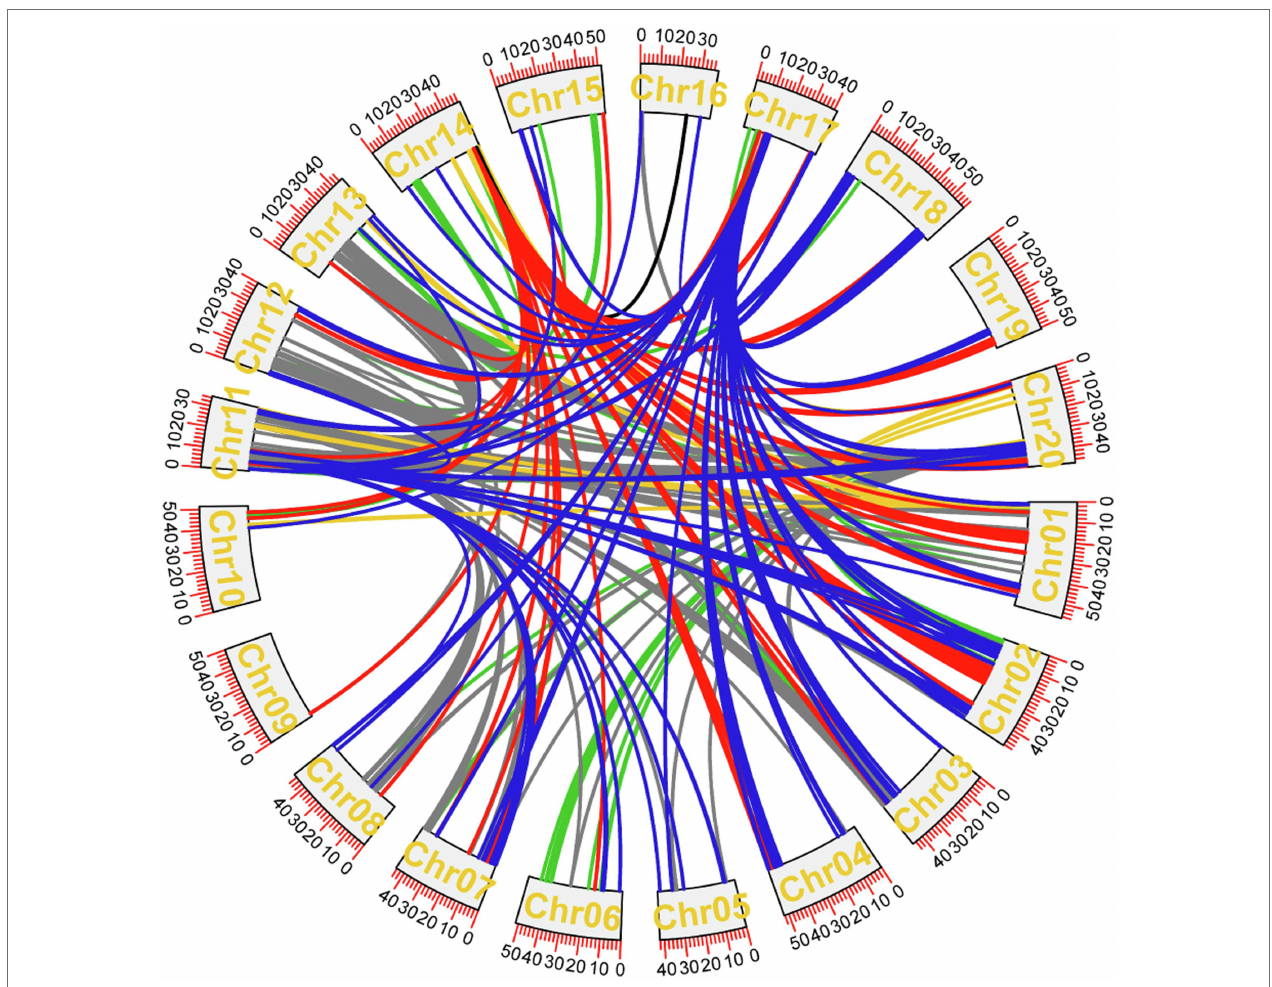
FIGURE 8 | Epistasis analysis of CSSLs. Epistasis of seed-pod traits that have repeatedly appeared over the years. Dark blue represents the epistatic effect among HSW loci, red represents the epistatic effect among PoOSPN loci, black represents the epistatic effect among SL loci, yellow represents the epistatic effect among SW loci, green represents the epistatic effect among PoTHSPN loci, gray represents the epistatic effect among PoTSPN